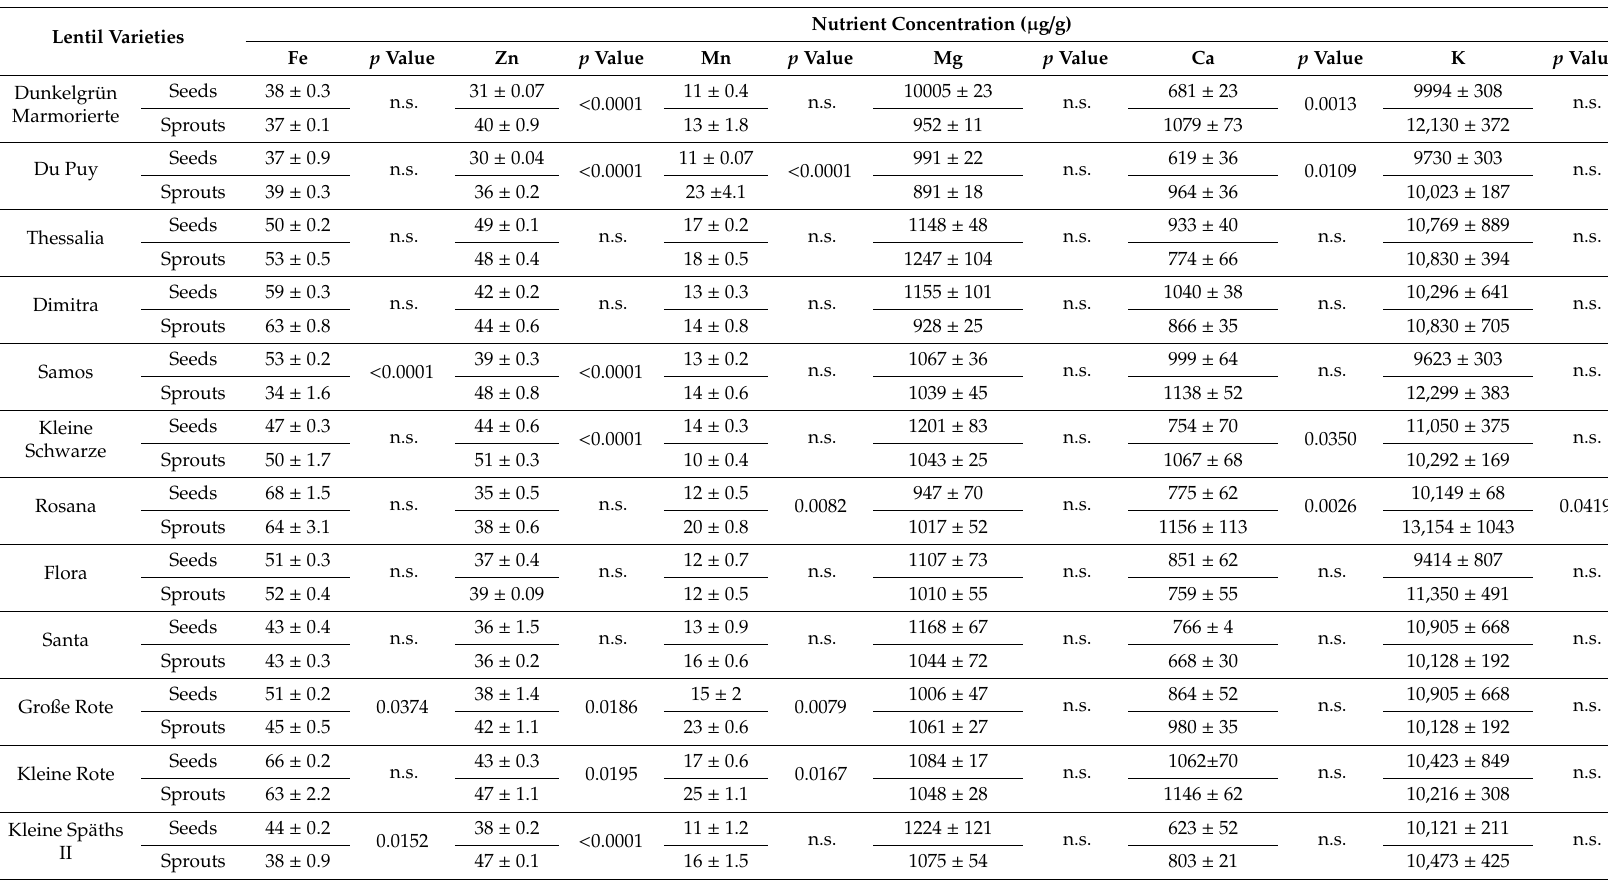
Table 1. Iron (Fe), zinc (Zn), manganese (Mn), magnesium (Mg), calcium (Ca) and potassium (K) concentration ( µ g / g) of the seeds and seed sprouts of 12 lentil varieties and correspondent P values of the di ff erences between them by ANOVA using Tukey’s Test. Lentil